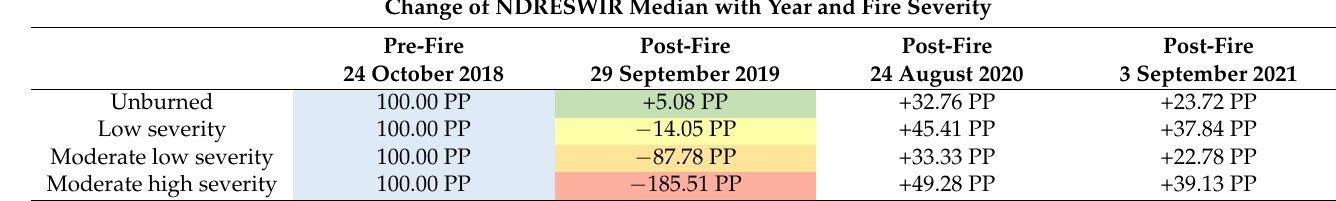
Table 8. Vegetation recovery according to the median NDRESWIR per fire severity class compared to the pre-fire year in percentage points (PP) at the El Saco basin.